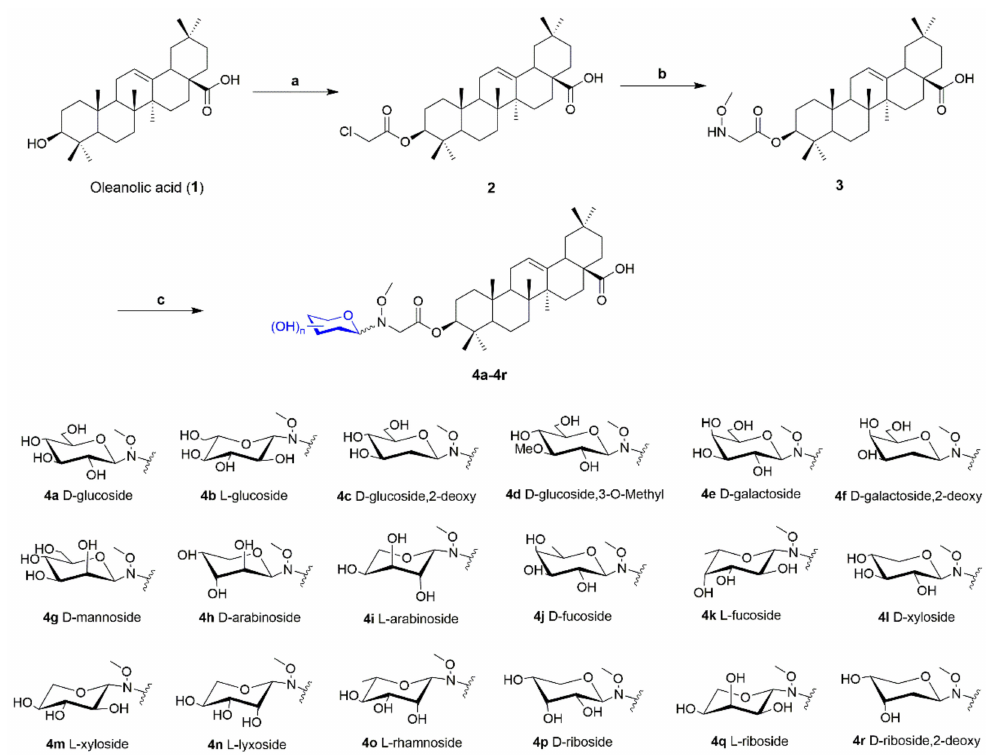
Scheme 1. Synthesis of oleanolic acid C-3-neoaglycone 3 and neoglycosides 4a – 4r . Reagents and conditions : ( a ) ClCH 2 COCl, DIPEA, DMAP, THF, rt, 2 h; ( b ) NaI, EtOH, 60 ◦ C, MeONH 2 in THF, every 2 h; ( c ) reducing sugars, MeOH: CHCl 3 (6:1), 40 ◦ C, 48